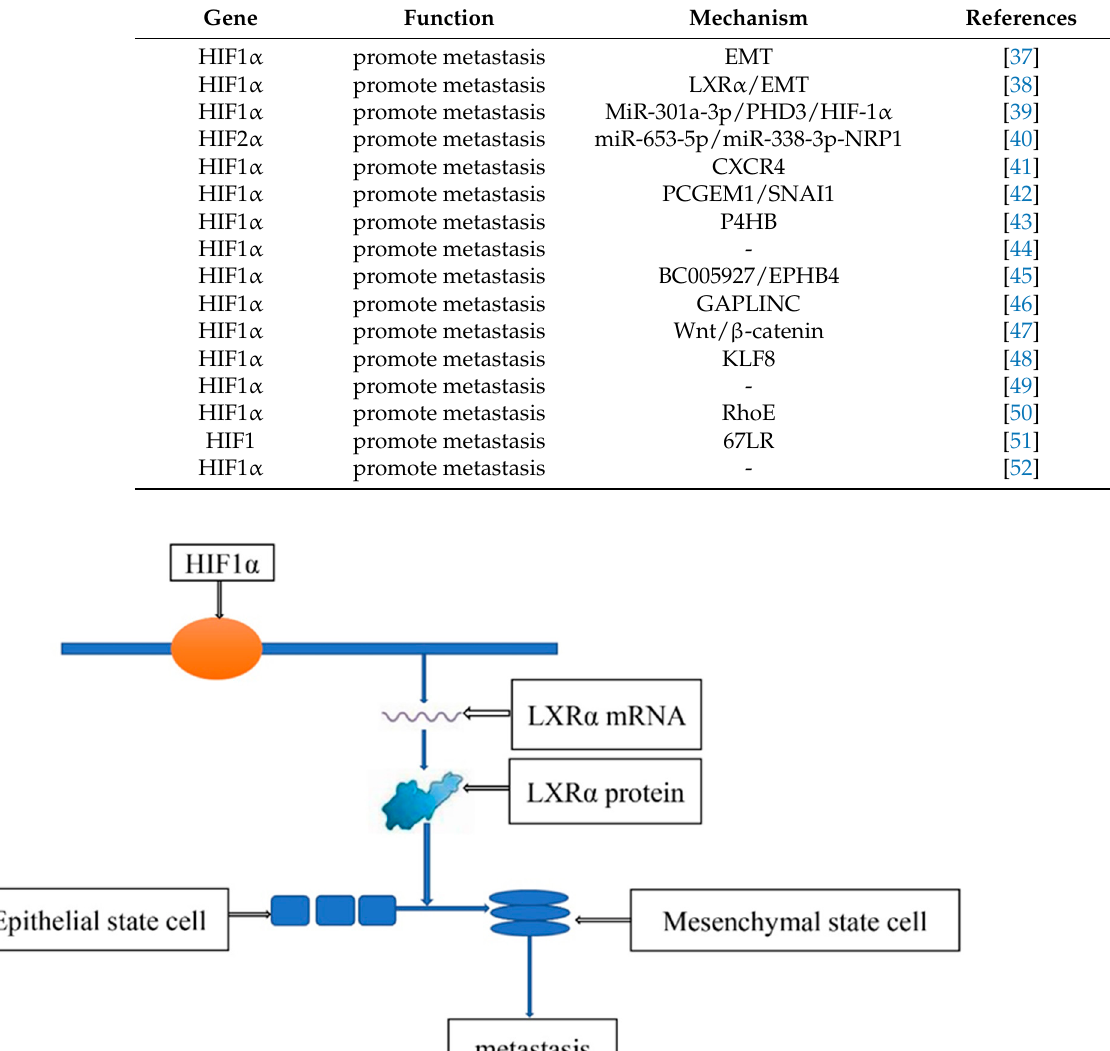
Table 2. HIF regulates gastric cancer progression by gastric cancer cell metastasis.